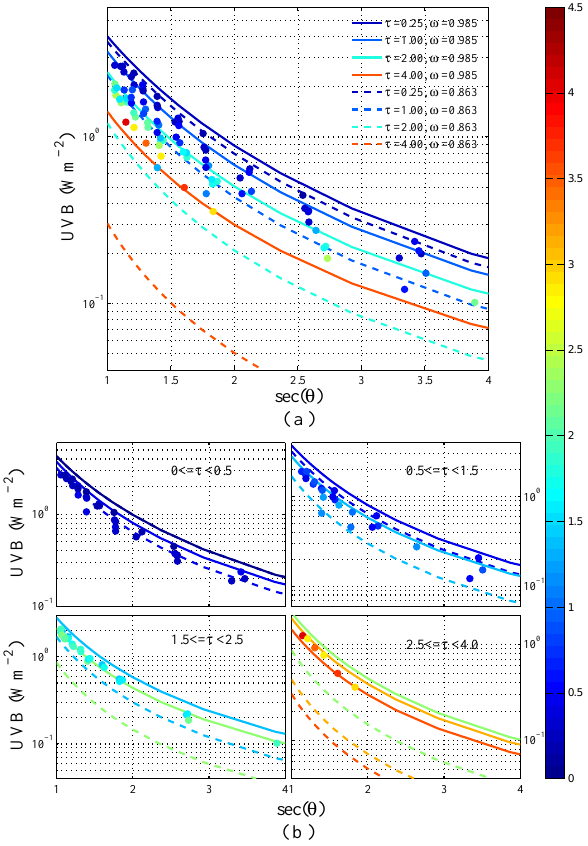
Figure 5. (a) The dots represent the measured UVB irradiance. The lines represents the modeled UVB irradiance at ω of 0.863 (dashed lines) and 0.985 (solid lines). Colors represent the value of τ , i.e., the warmer/colder the color is, the higher/lower τ is re- vealed. (b) Identical to (a) but with finer ranges of τ as shown in the figures.